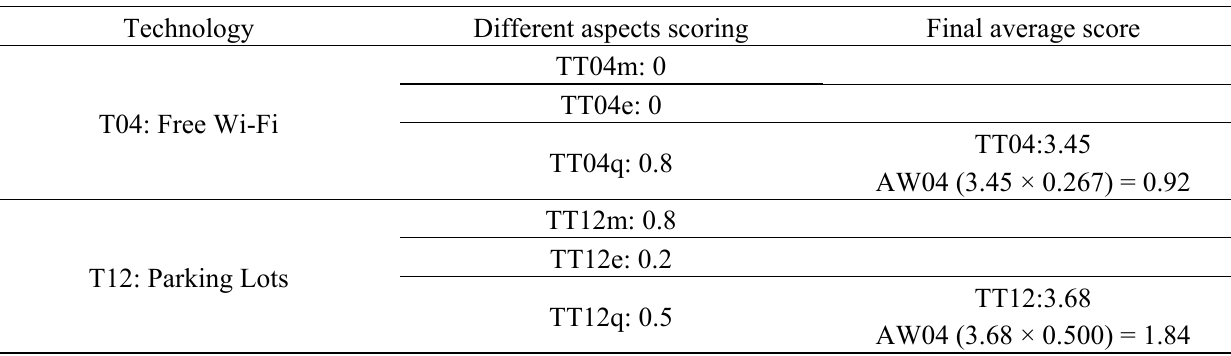
Table 6. Evaluation